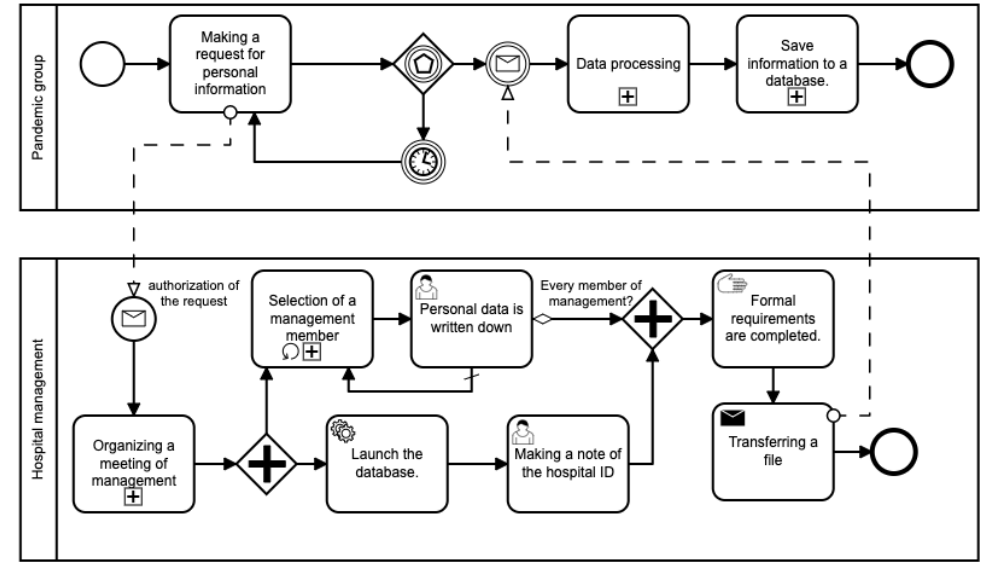
Figure 5. Important data measurements.